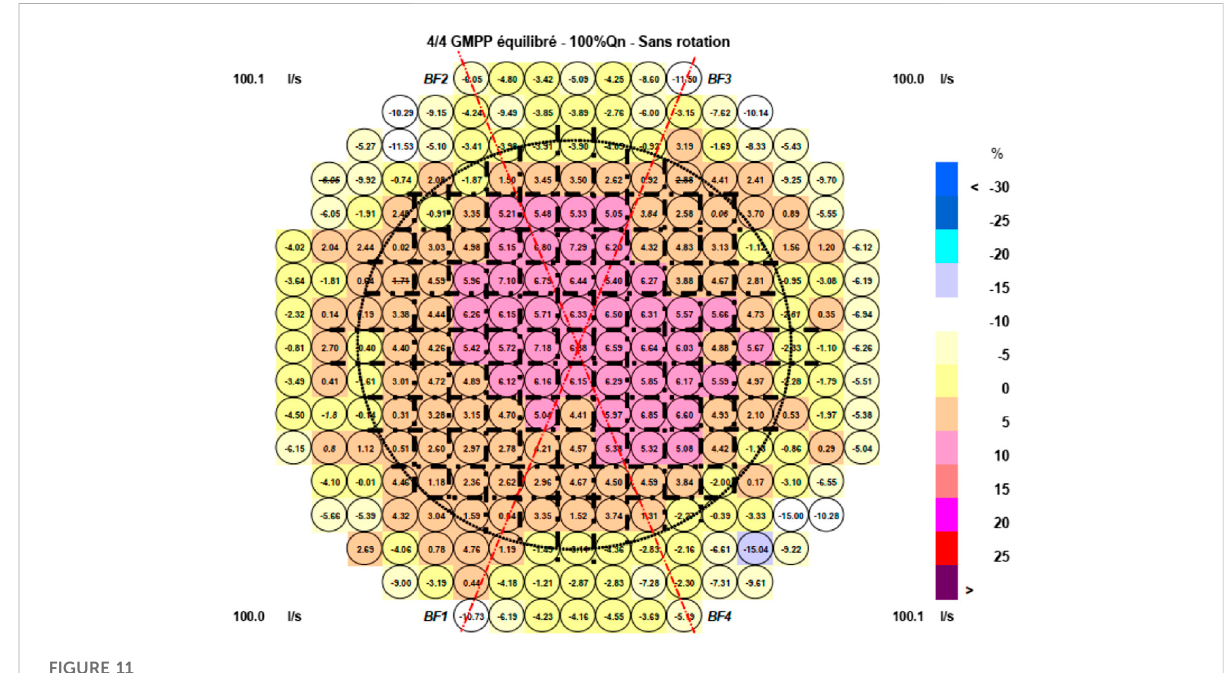
FIGURE 11 Distribution of inlet rate of fl ow of EPR core.